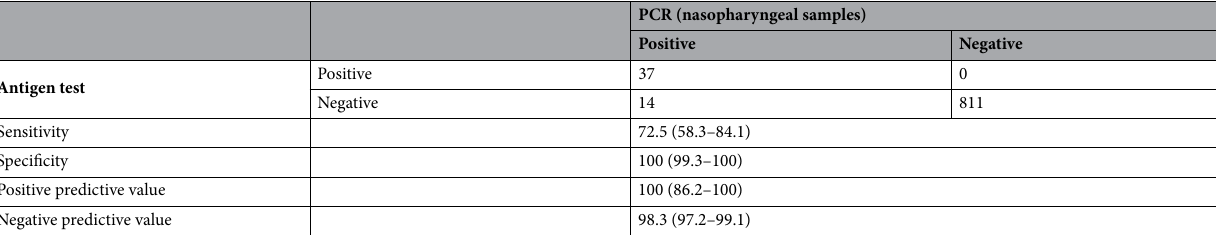
Table 3. Clinical performance of antigen test using anterior nasal samples. Sensitivity, specificity, positive predictive value, and negative predictive value are provided with 95% confidence intervals.